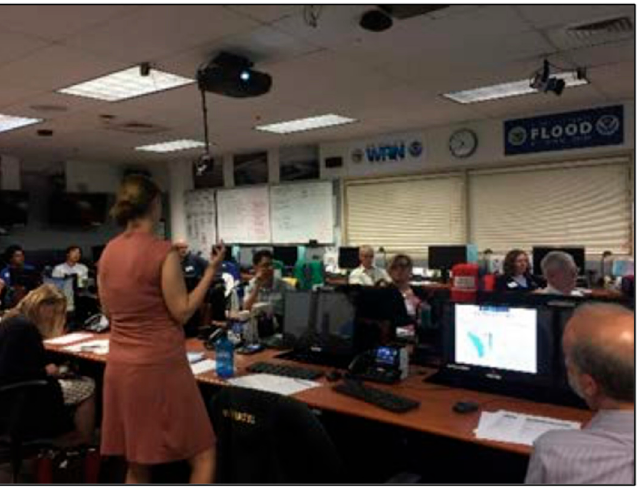
Figure 10. Photo captured during the TTE held at the CA-DWR Flood Operations Center demon- strating the Hydro-CosMoS.